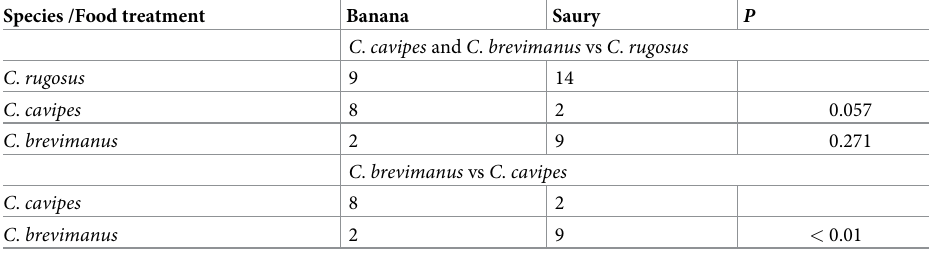
Table 5. Differences in dietary preferences of three terrestrial hermit crab species P = probability (Fisher’s exact test). Species /Food treatment